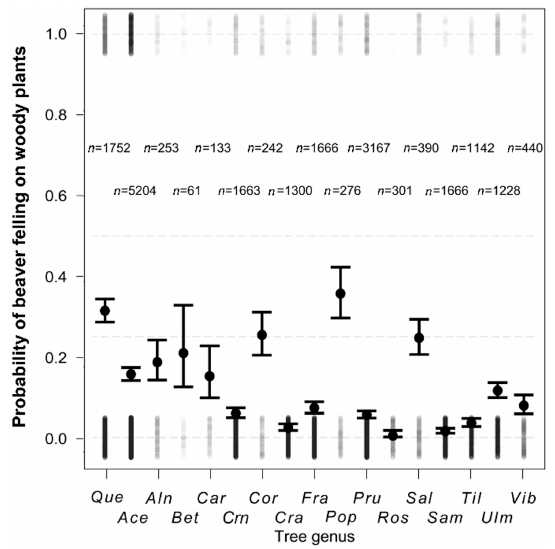
Figure 2. Probability of beaver felling on 17 individual woody plant genera (mean ± SE) after controlling the effect of spatial variance, distance from water, and diameter of trunk. Que — Quercus , Ace — Acer , Aln — Alnus , Bet — Betula , Car — Carpinus , Crn — Cornus , Cor — Corylus , Cra — Crataegus , Fra — Fraxinus , Pop — Populus , Pru — Prunus , Ros — Rosa , Sal — Salix , Sam — Sambucus , Til — Tilia , Ulm — Ulmus , Vib — Viburnum